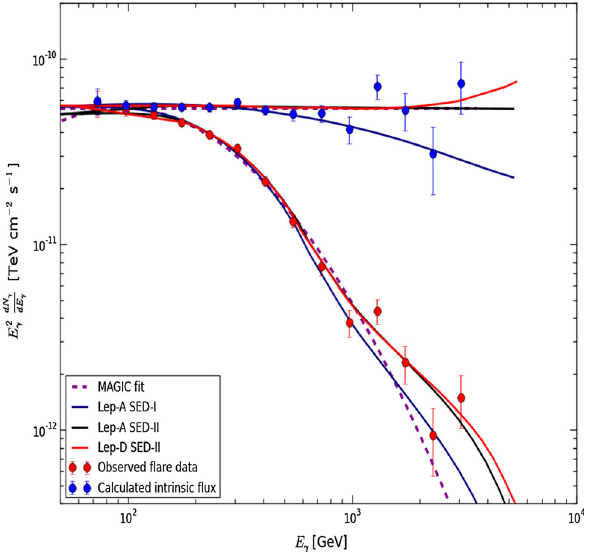
Fig. 3 Using the leptonic models of Albert et al. (Lep-A) and Domínguez et al. (Lep-D) with the EBL correction, the multi-TeV flare data are fitted in the photohadronic model (lower curves) and the cor- responding intrinsic fluxes are also shown (upper curves). The lower and the upper curves of the same color belong to a single model. For comparison the MAGIC fit to the observed flux (lower magenta dashed curve) and the intrinsic flux (upper magenta dashed curve) are